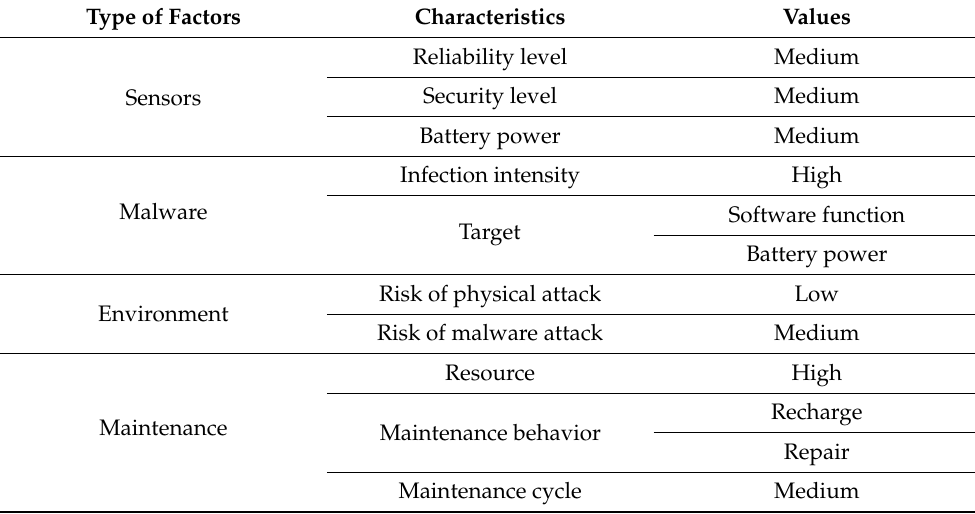
Table A4. Scenario 2 with characteristics and values.